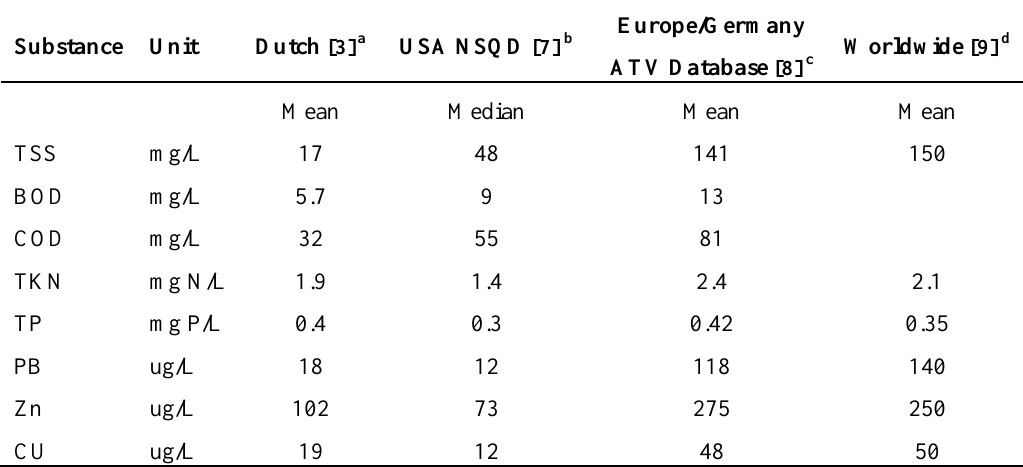
Table 3. Dutch and international stormwater quality data from residential areas in USA, Australia, and